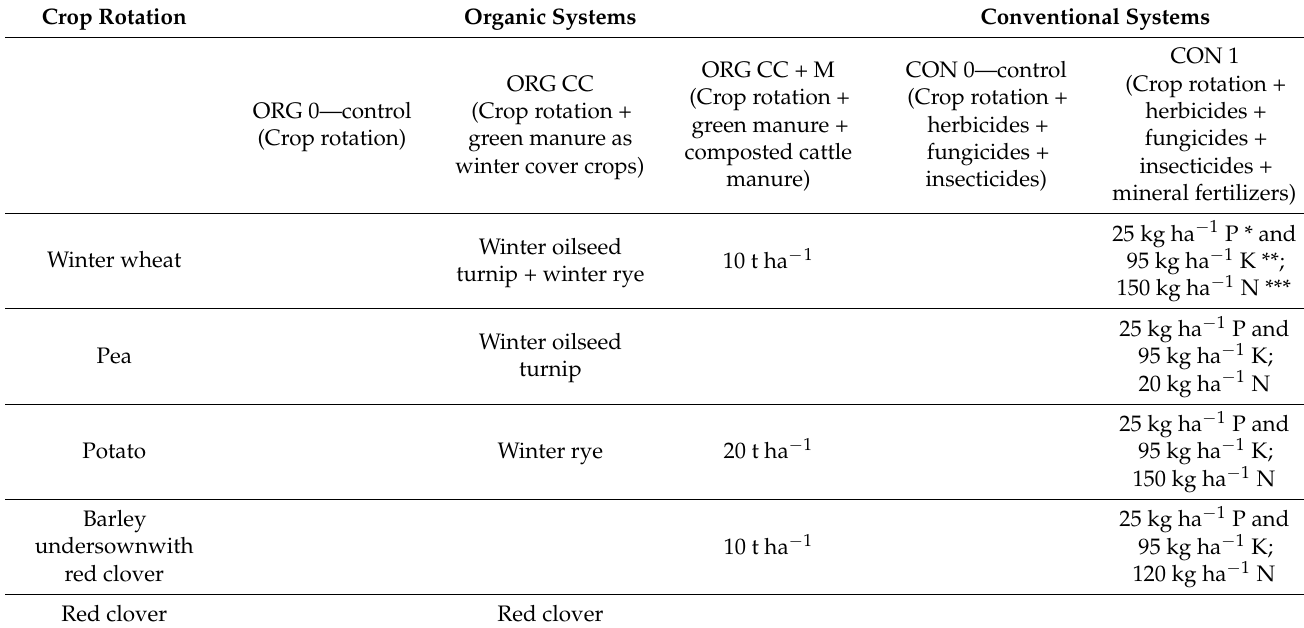
Table 1. The treatments in the organic and conventional farming systems Matsen et al.